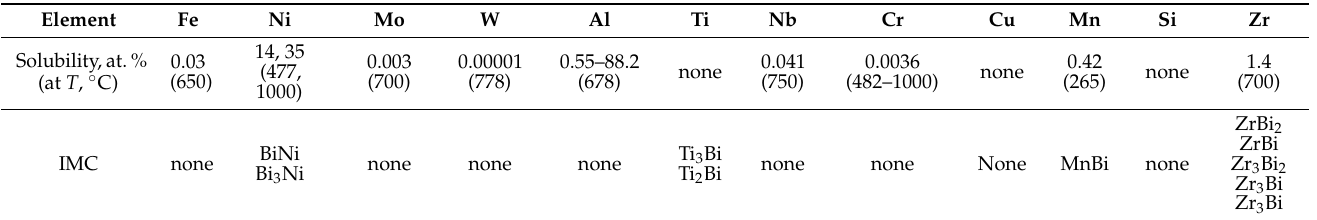
Table 1. Solubility of metals in bismuth and possible intermetallic compounds formed in the corre- sponding binary systems.